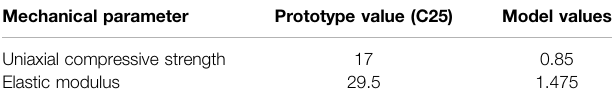
TABLE 6 | Comparison of concrete materials of tunnel basement structure.